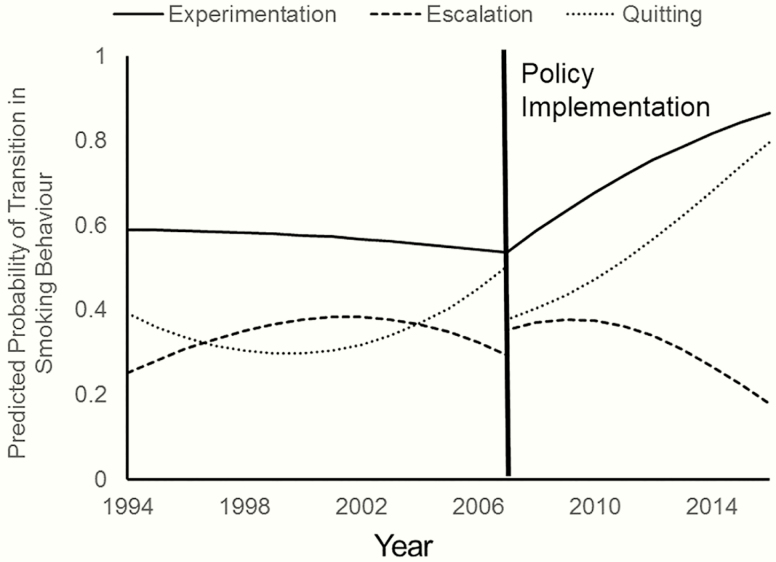
The effect of policy implementation on experimentation, escalation, and quitting. Predicted probabilities are calculated based on the change in legal age models from Supplementary Table 3, for age 15 females in England, with average parental education, e-cigarette prevalence at 0, and the tobacco excise duty rate held constant.